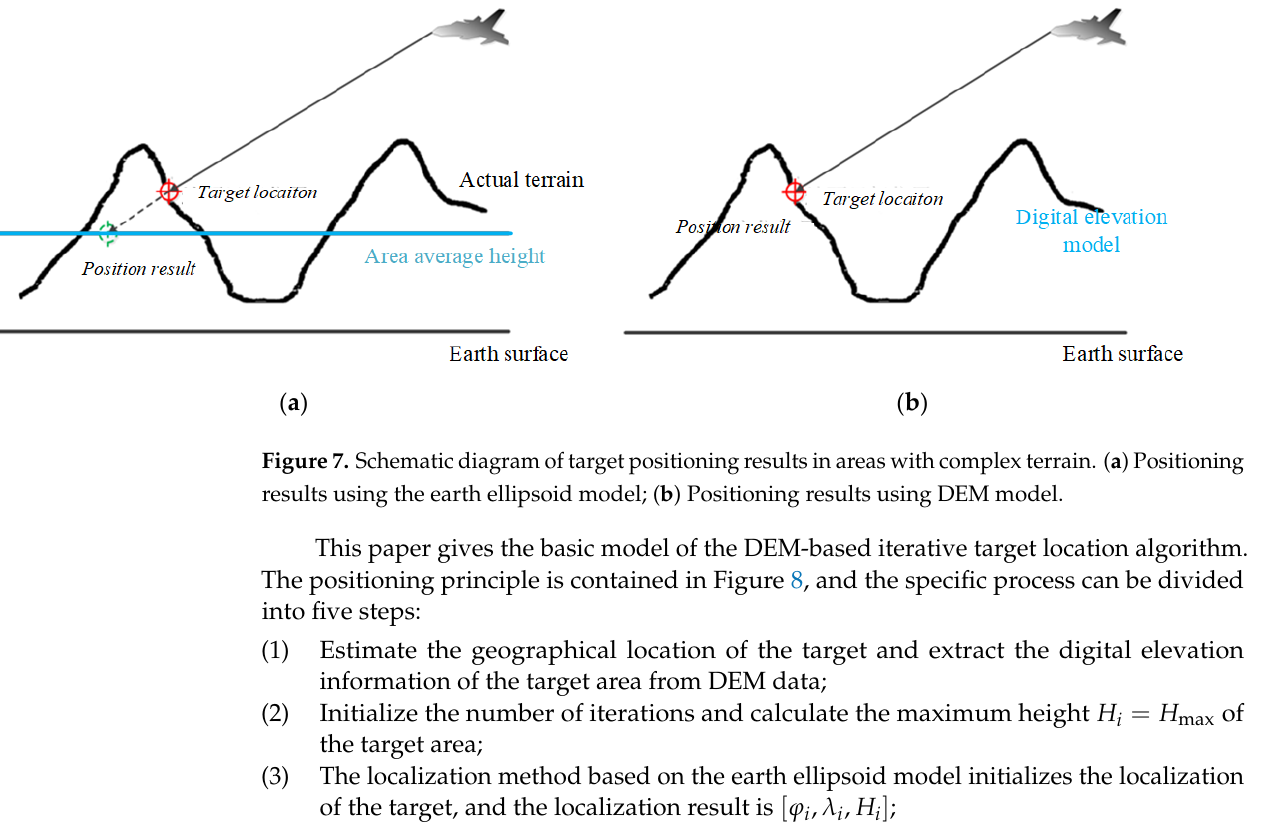
Figure 7. Schematic diagram of target positioning results in areas with complex terrain. ( a ) Posi- tioning results using the earth ellipsoid model; ( b ) Positioning results using DEM model.